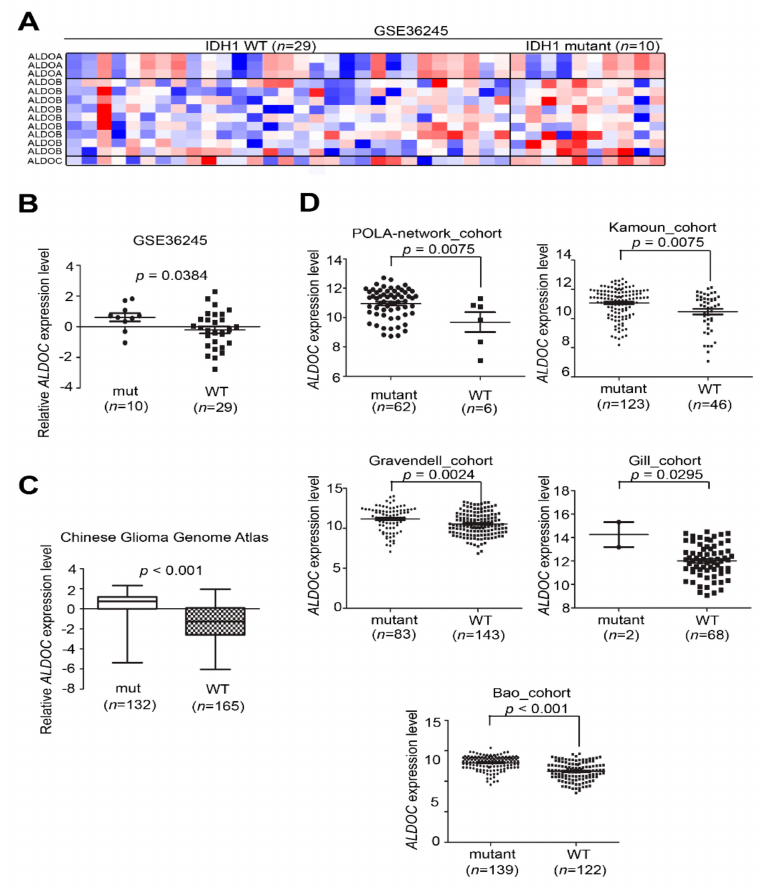
Figure 4. ALDOC mRNA expression associated with IDH1 mutation event in silico data sets. ( A ) A heat map showing the endogenous mRNA expression level of aldolase family members ALDOA, ALDOB, and ALDOC in GSE36245 ( n = 38). ( B ) A boxplot showing the distribution of ALDOC expression in clinical patients according to the IDH1 mutant event in the GSE36245 cohort ( p = 0.0384). ( C ) A boxplot showed the distribution of ALDOC expression in clinical patients according to the IDH1 mutant event in the CGGA cohort ( p < 0.001). ( D ) A boxplot showing the distribution of ALDOC expression in clinical patients according to the IDH1 mutant event in several cohorts (POLA-network: p = 0.0075, Kamoun: p = 0.0075, Gravendell: p = 0.0024, Gill: p = 0.0295, and Bao: p < 0.001, respectively). The